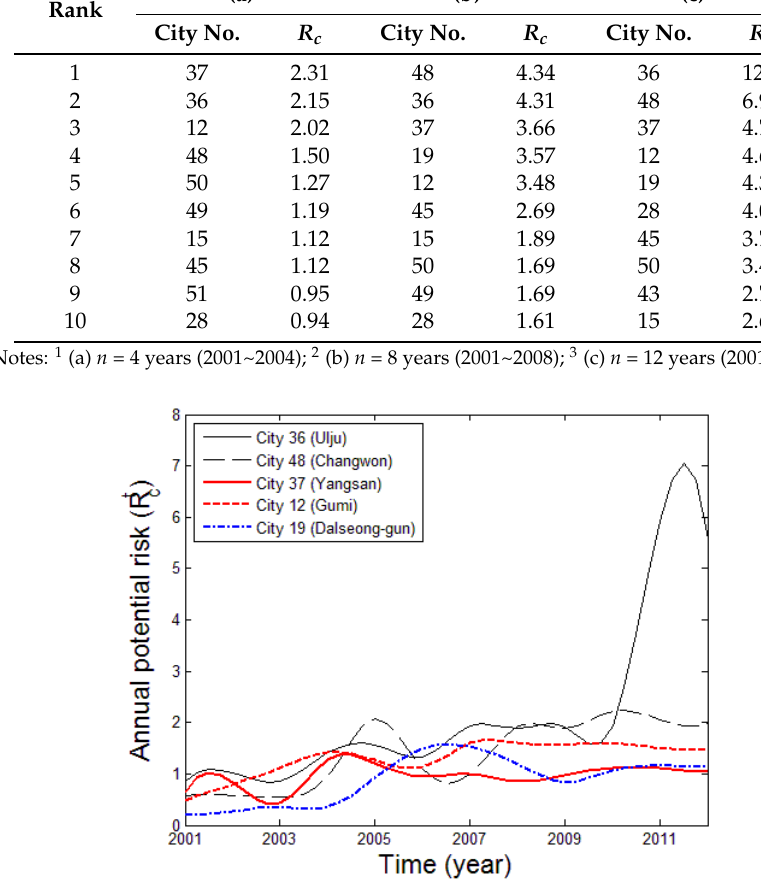
11 of 13 Table 4. The ranking table of potential risk (R c ) of cities in the Nakdong River Basin. Rank